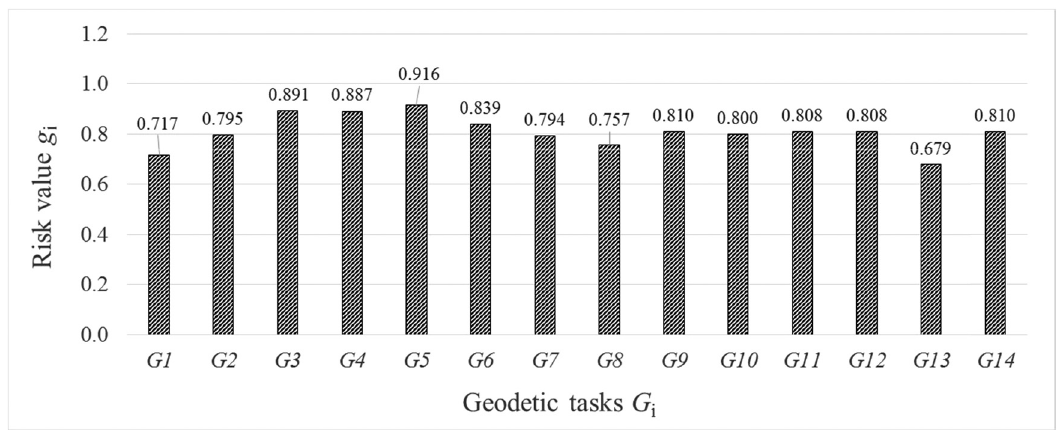
Figure 4: The risk value for the i - th geodetic task taking account of all criteria.